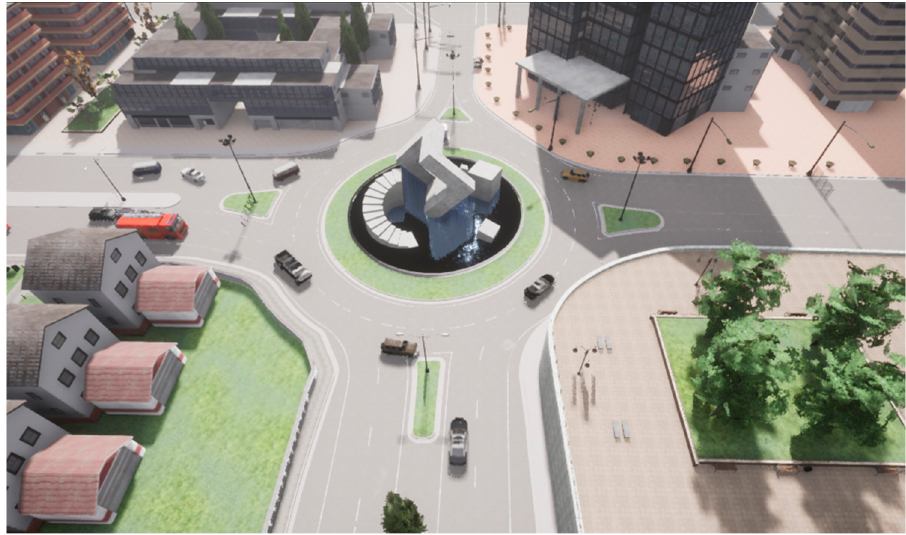
Figure 14. CARLA roundabout traffic flow.